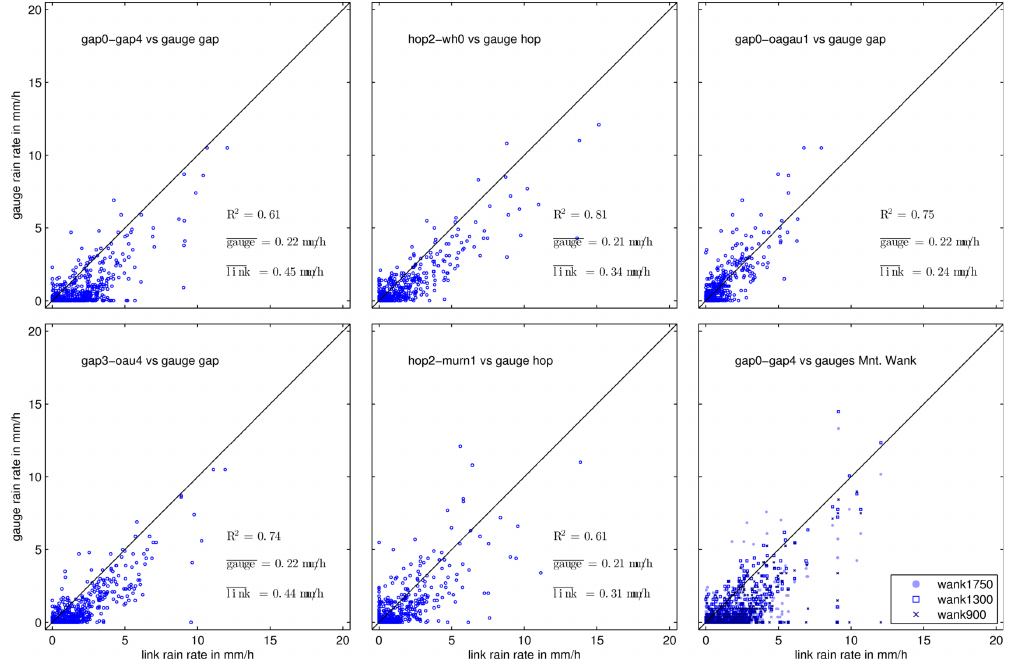
Fig. 8. Scatter plots for continuous hourly microwave link rain rate observation and DWD rain gauge data for the period from July 2010 to October 2010. The plot on the bottom right shows gauge data from the rain gauges at different altitudes on Mount Wank directly beneath the link path.